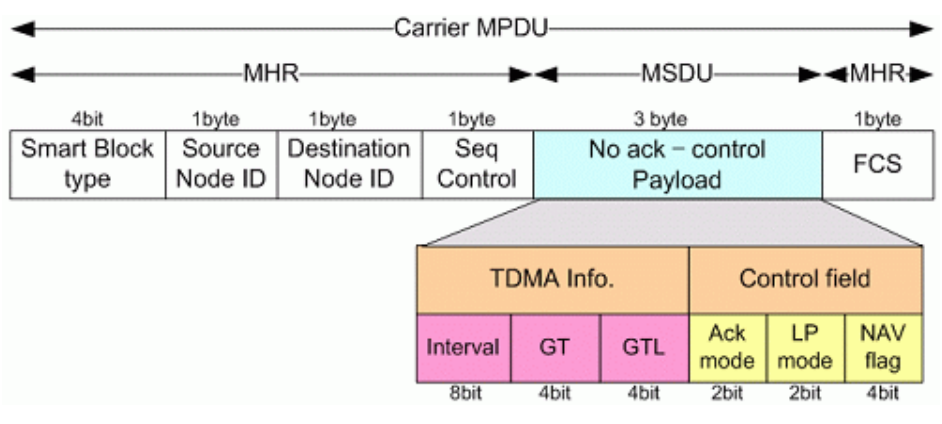
Figure 8. Beacon Frame with NA.